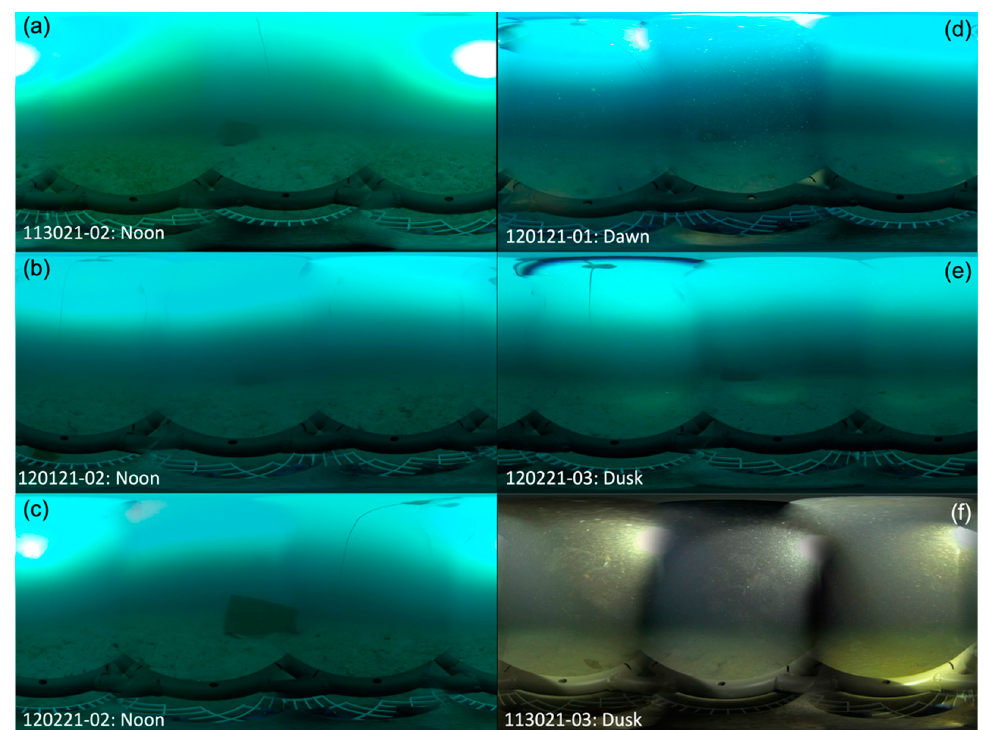
Figure 6. Selection of screenshots from the deployments in La Jolla, CA, showing the distance of the anchor from the lander and the variability in target visibility between deployments: ( a – c ) three noon deployments without external lights; ( d ) late dawn deployment with external lights; ( e ) early dusk deployment with external lights; and ( f ) late dusk deployment with external lights. The stitch marks between the three videos, delimiting the viewing frames, are visible as vertical lines on the images, and the anchor is centered in the background.